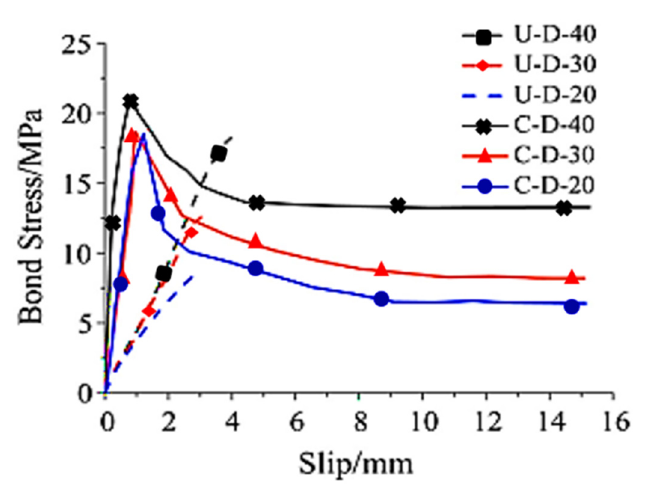
Figure 11. Bond–slip behavior of the di ff erent steel rebars. (U or C) for uncon fi ned or con fi ned, (D) for deformed bar, (20, 30, 40) for concrete strength grade (Adapted with permission from reference